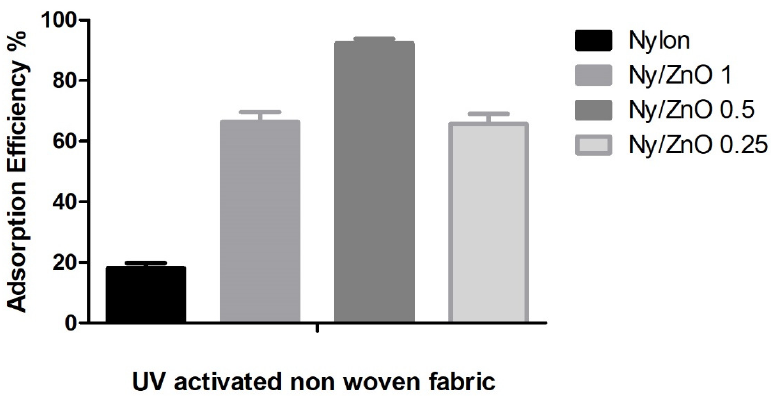
Figure 7. The adsorption efficiency of nylon, Ny/ZnO 1, Ny/ZnO 0.5, Ny/ZnO 0.25 UV activated non-woven fabric (MB concentration = 200 mg/L, nanocomposite content = 20 mg/20 mL, T = 25 °C and t = 60 min).